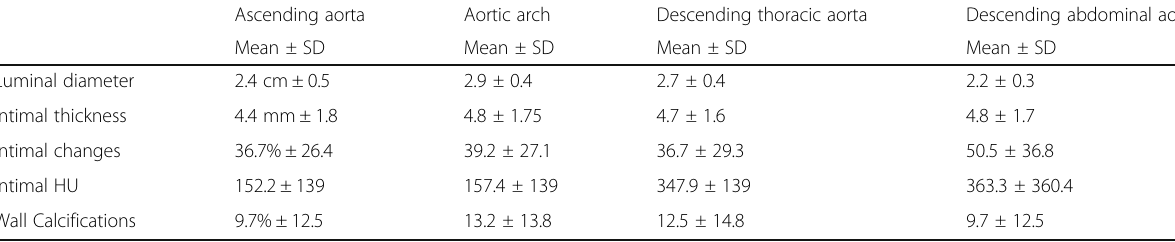
Table 1 CT findings in the 50 patients of study population Ascending aorta